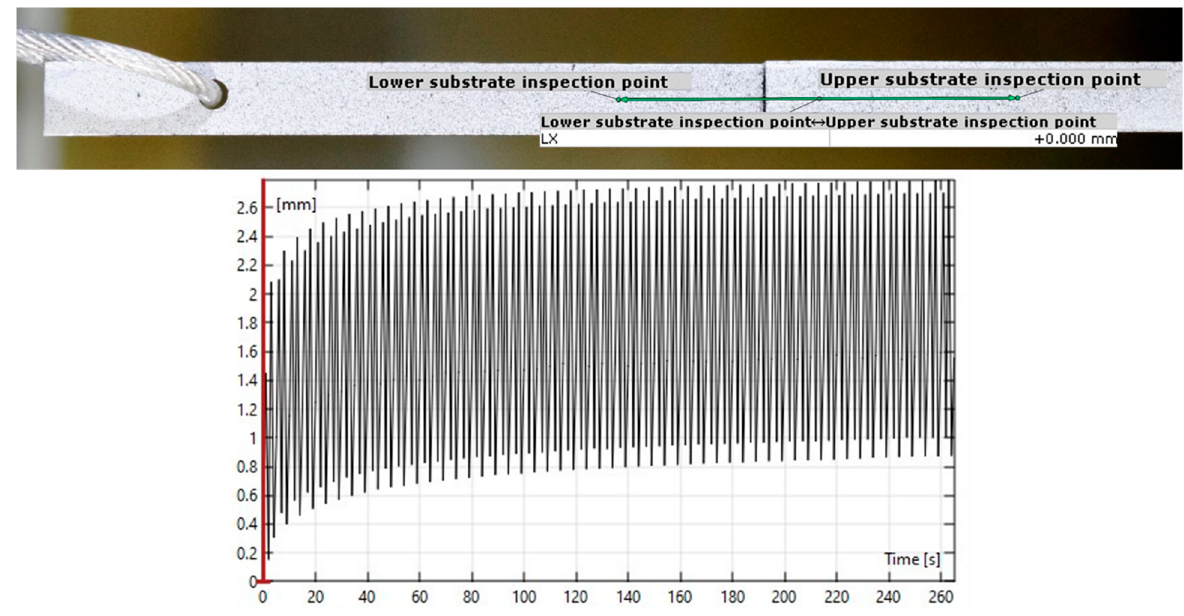
Figure 6. DIC analysis of a cyclic creep test: marked inspection points ( top ) and the resulting plot of the displacement through the test ( bottom ).